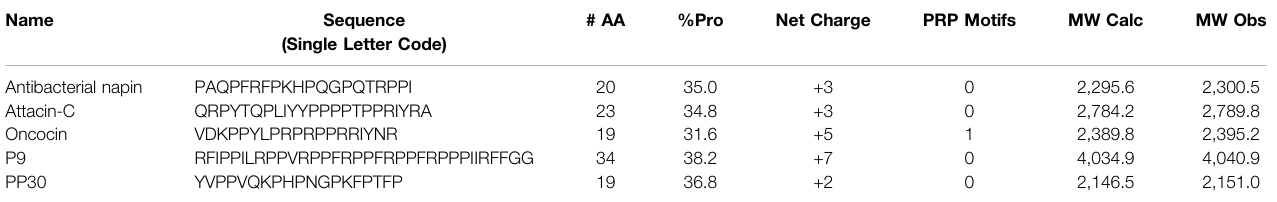
TABLE 1 | Predicted PrAMPs used in this study. The known PrAMPs and control PrAMP, oncocin, is included for reference. Each peptide was synthesized with a C-terminal amide.